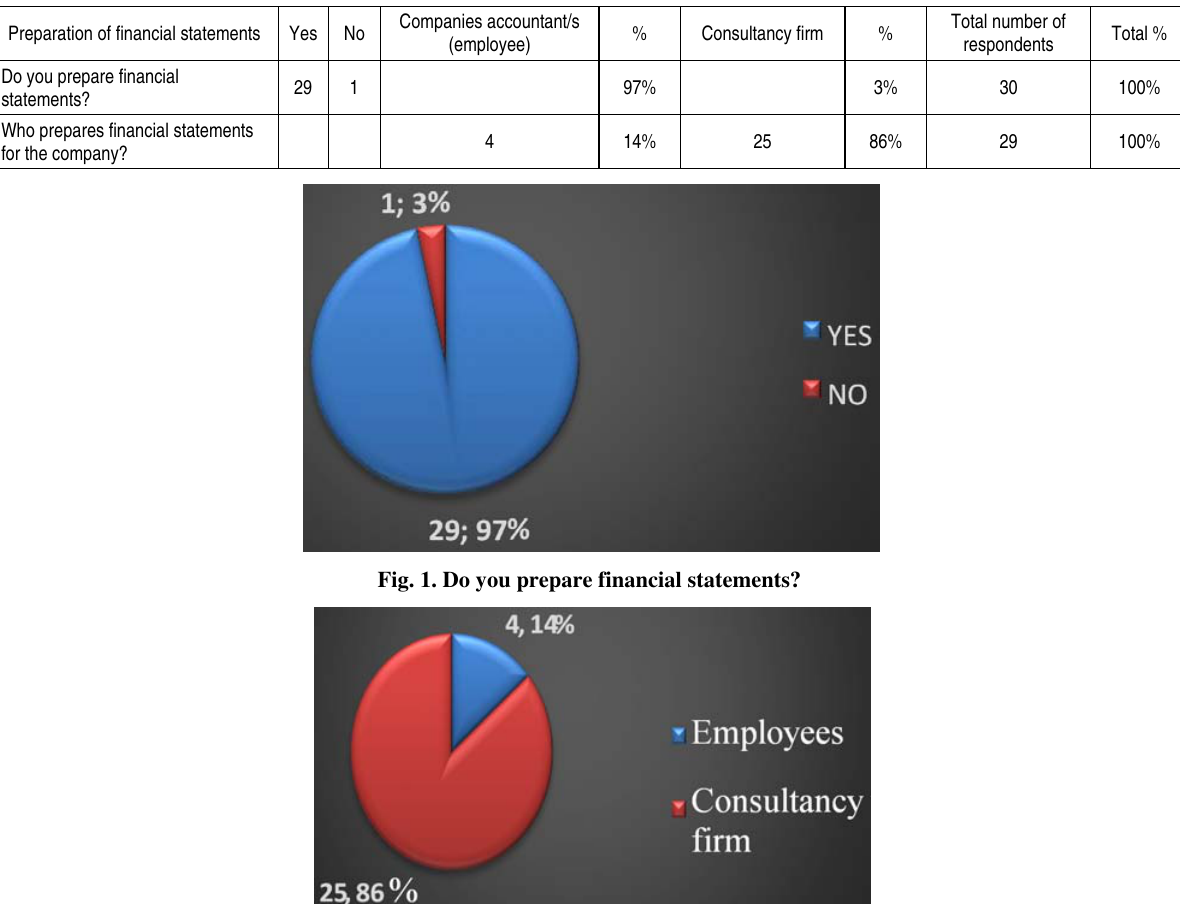
Fig. 2. Who prepares the financial statements?